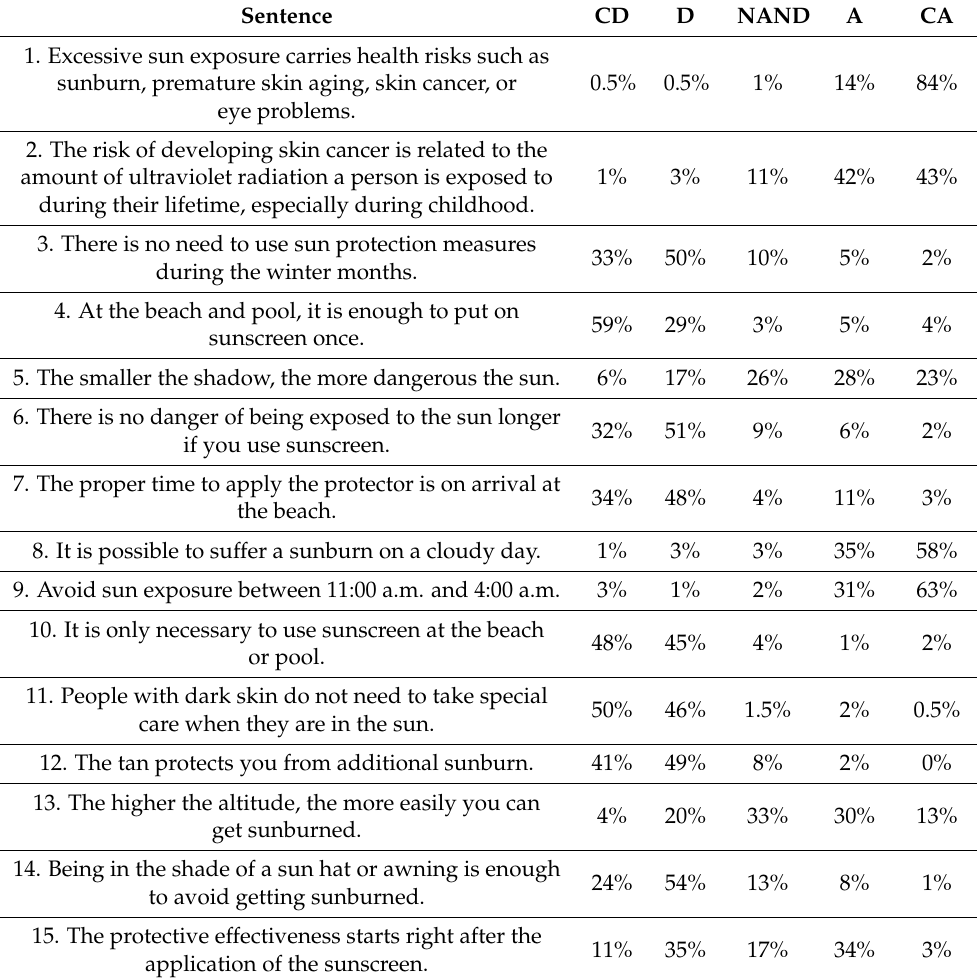
Table 1. Results in percentage (%) on caregivers’ knowledge regarding exposure and sun protection of children and